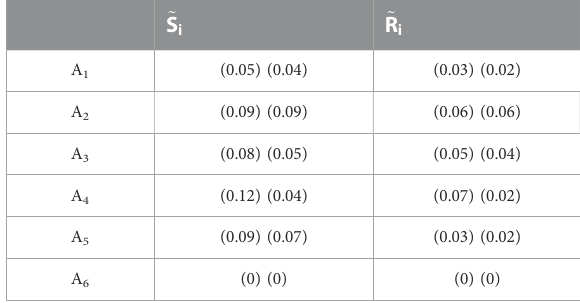
TABLE 9 Defuzzi fi ed values of ~ S i and ~ R i